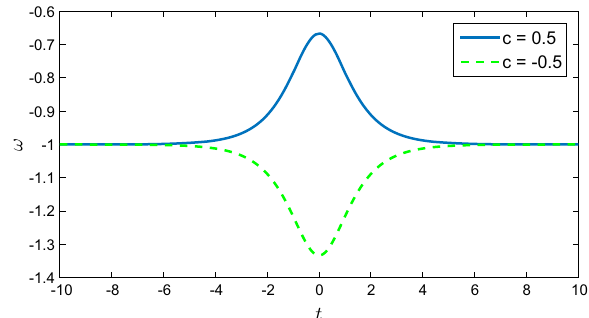
Fig. 1 Plot of the parameter ω given by Eq. (21), for the parameter values c = ± 0 . 5, s = 1 and t 0 =